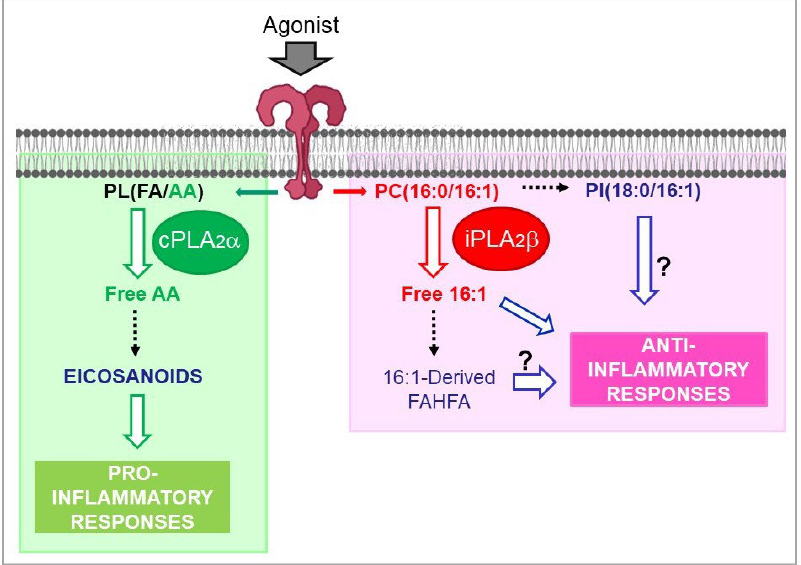
Figure 4. Phospholipase A 2 -mediated signaling in activated macrophages. The macrophages utilize two cytosolic phospholipase A 2 s of similar size but with clearly differentiated functions, to effect lipid signaling leading to either pro- or anti-inflammatory actions. On the one hand, group IVA calcium-dependent phospholipase A 2 (cPLA 2 α) releases arachidonic acid (AA) from membrane phospholipids, giving rise to the formation of pro-inflammatory eicosanoids. On the other hand, group VIA calcium-independent phospholipase A 2 (iPLA 2 β) controls the metabolism of hexadecenoic fatty acids (palmitoleic acid, hypogeic acid, and sapienic acid), thus regulating new lipid metabolic pathways with anti-inflammatory character. The abbreviation PL(FA/AA) represents any given phospholipid (PL) containing an unspecified fatty acid (FA) at the sn-1 position, and arachidonic acid (AA) at the sn-2 position. PC(16:0/16:1), 1-palmitoyl-2-hexadecenoyl- sn -glycero-3-phosphocholine; PI(18:0/16:1), 1-stearoyl-2-hexadecenoyl- sn -glycero-3-phospho- inositol; FAHFA, branched fatty acyl esters of hydroxy fatty acids.